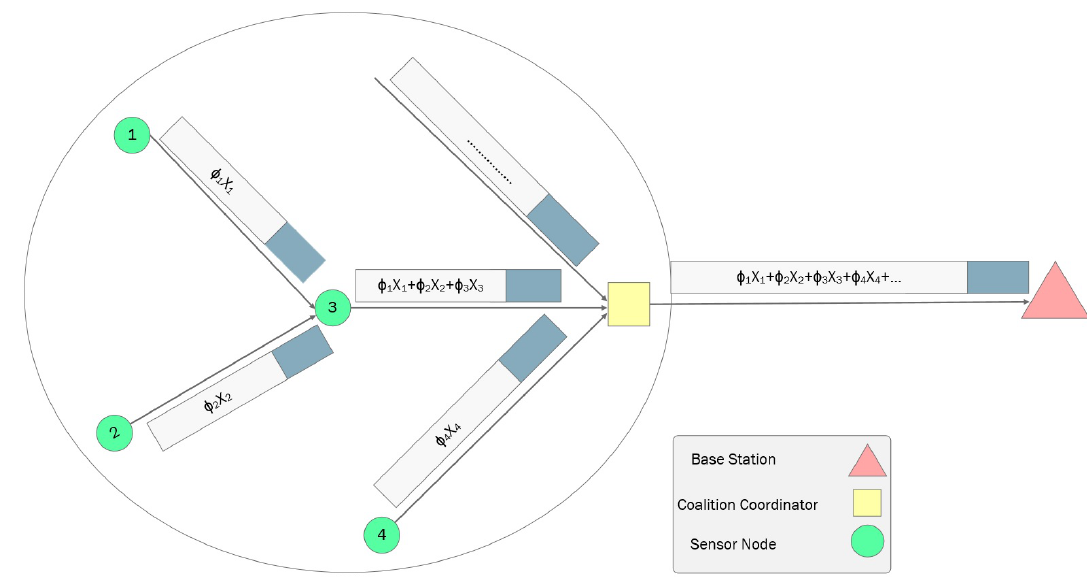
Figure 7. An example gathering